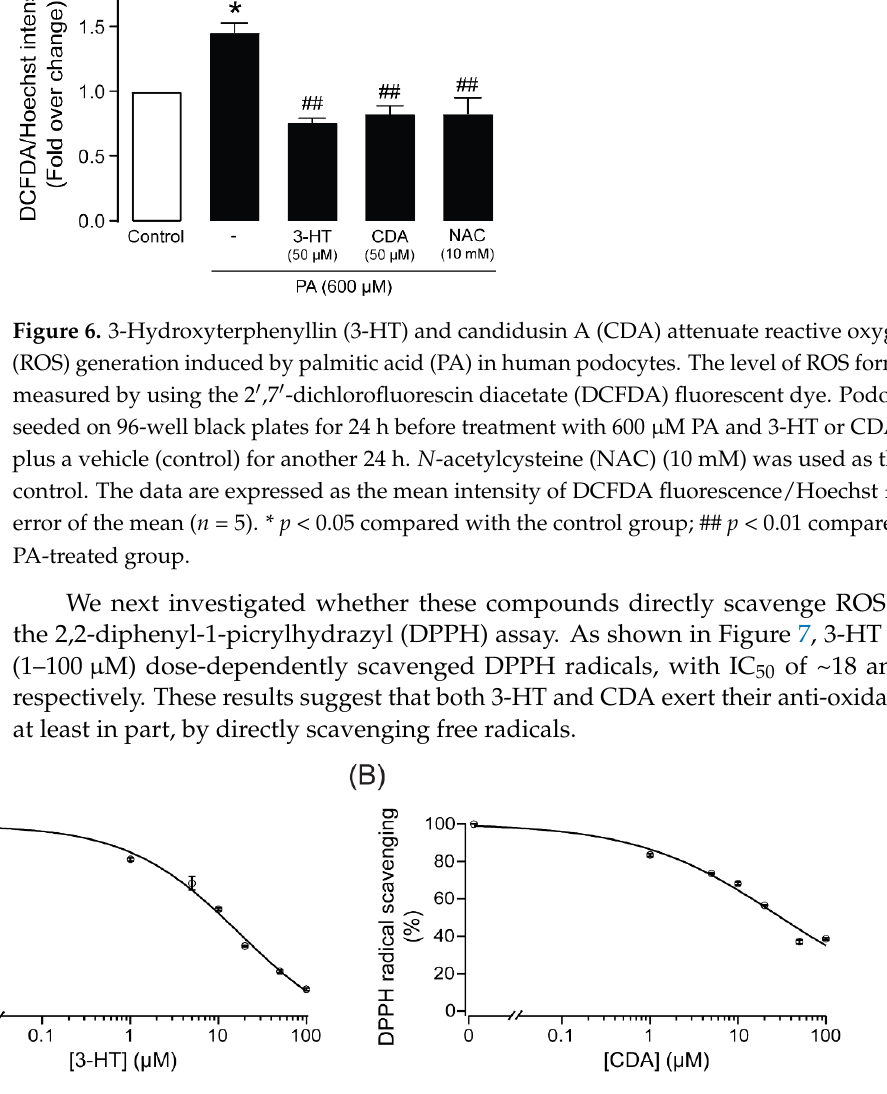
Figure 8. 3 ‐ Hydroxyterphenyllin (3 ‐ HT) and candidusin A (CDA) upregulate the anti ‐ apoptotic Bcl ‐ 2 protein. Podocytes were cultured in 6 ‐ well plates and then incubated with 600 μ M palmitic acid (PA) in the presence or absence of 50 μ M 3 ‐ HT or CDA for 24 h. N ‐ acetylcysteine (NAC) (10 mM) was used as a positive control. Western blot analysis was performed ( n = 6). The data are expressed as the band intensity of Bcl2/Bax ( n = 6). * p < 0.05 compared with the PA ‐ treated group.